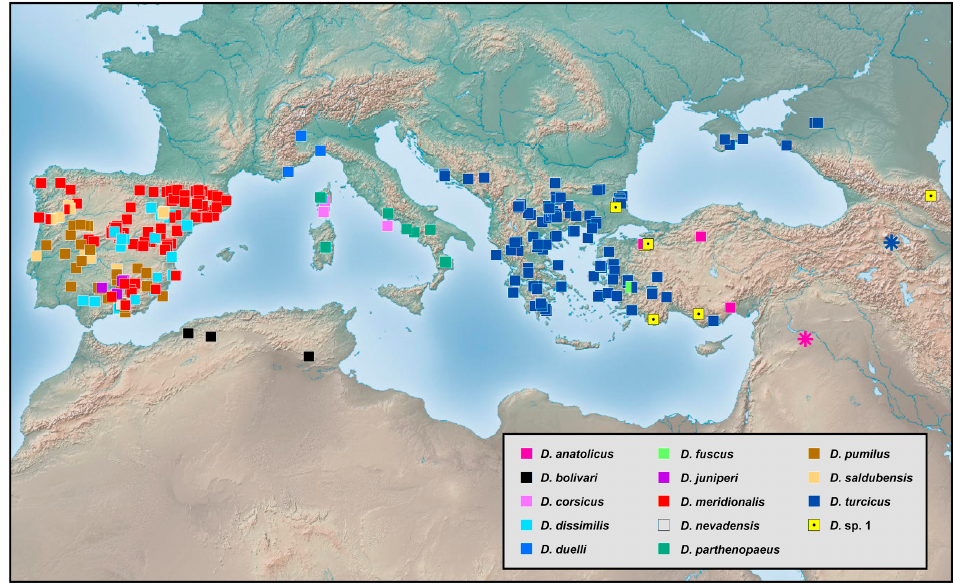
Figure 20. Distribution map of the species of Dilar from Europe, North Africa and West Asia. (Region 1 in Figure 19) Asterisk indicates specimen with imprecise locality.